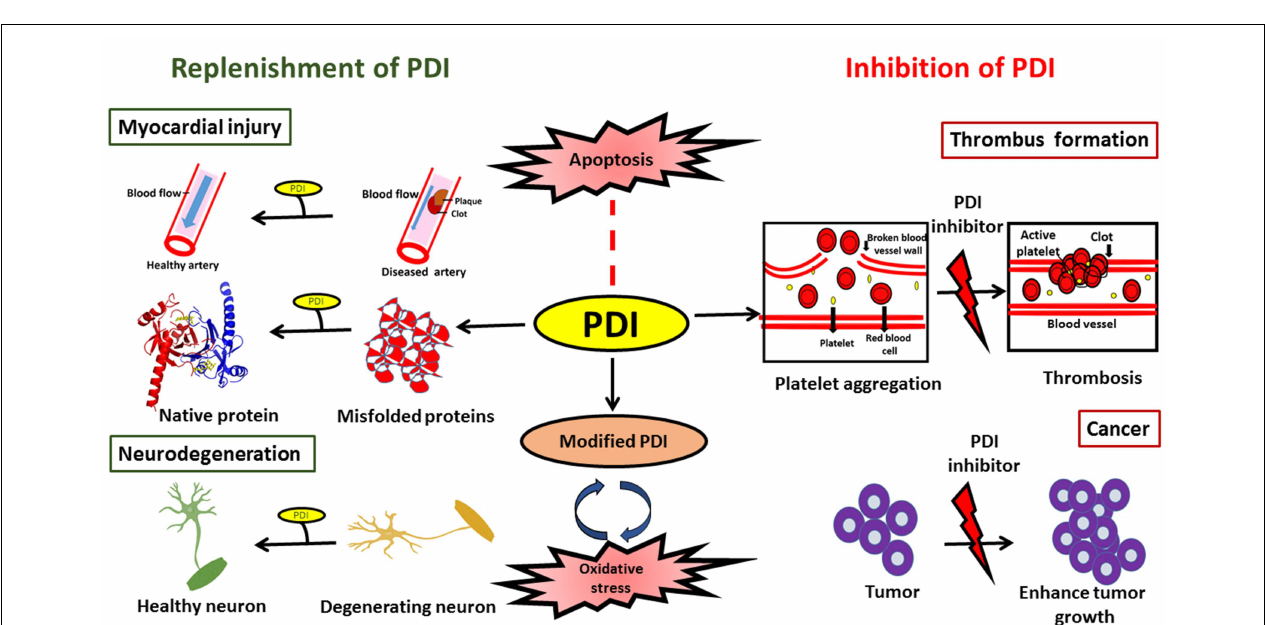
FIGURE 3 | Schematic diagram outlining the dual nature of PDI, focusing on neurodegenerative disorders as an example. Under normal conditions, PDI reduces the load of misfolded proteins either by its chaperone activity or by isomerization of